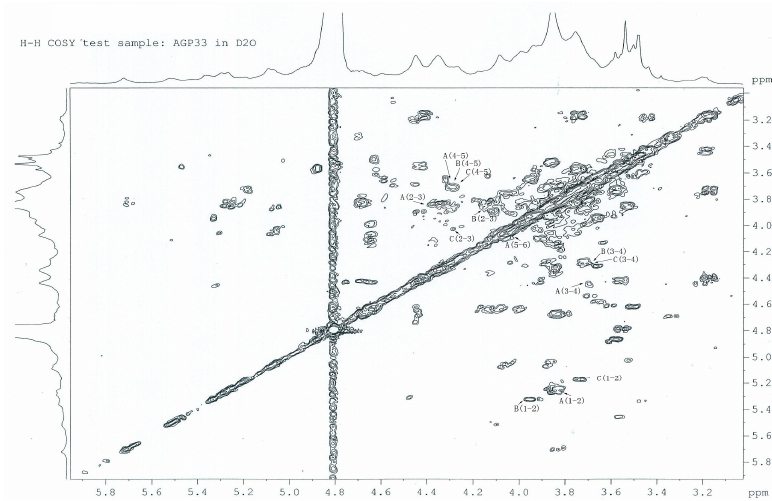
Figure 4. H, H-COSY spectrum of AGP33. The cross-peaks were showed the correlate of two adjacent hydrogen atom of each residue in which 1,3- D -Glc p , 1,4- D -Gal p and 1,6- D -Glc p referred to residues A, B and C respectively.